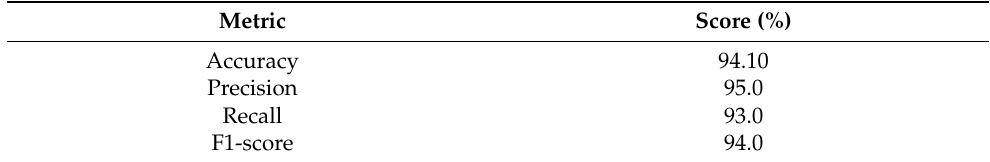
Table 5. Test Set